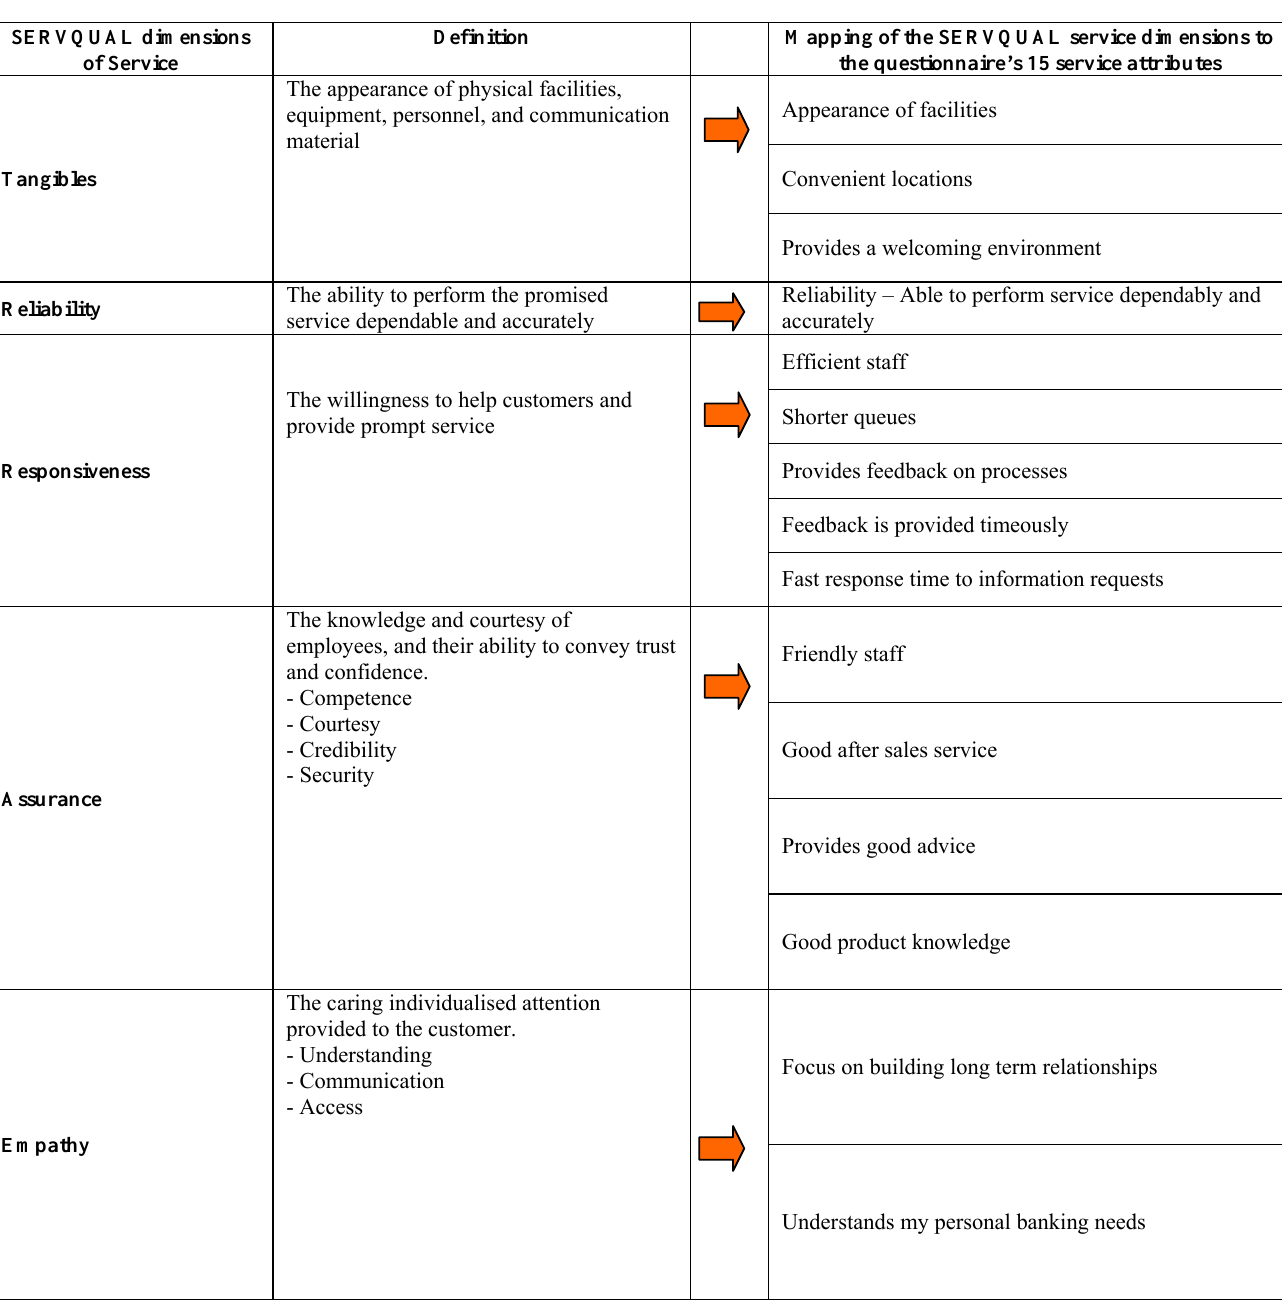
Table 1: Mapping of service attributes to SERVQUAL dimensions SERVQUAL